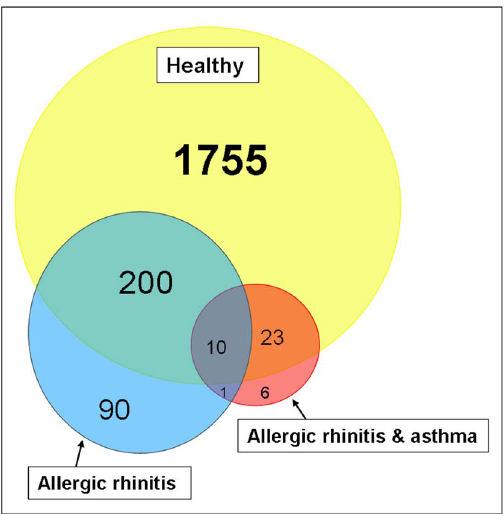
Figure 1. Venn diagram of the significantly differentially expressed genes between upper and lower